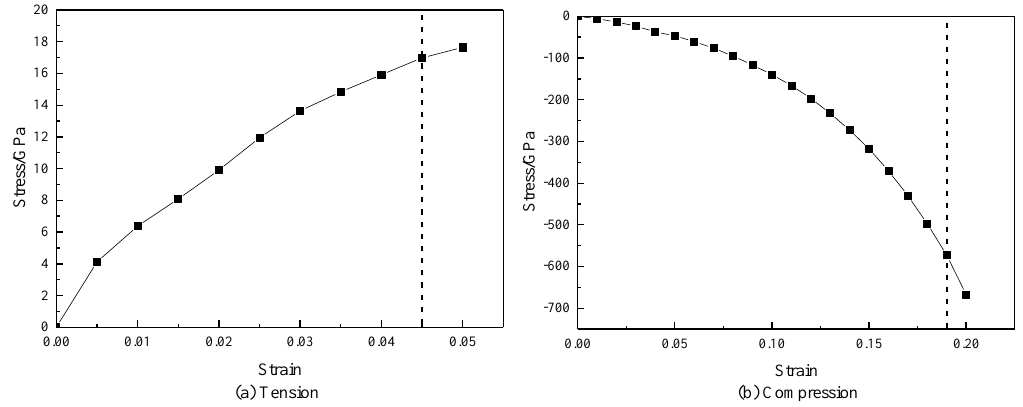
Figure 5. Stress–strain curve in the process of tension and compression. ( a ) tension, and ( b ) compression.